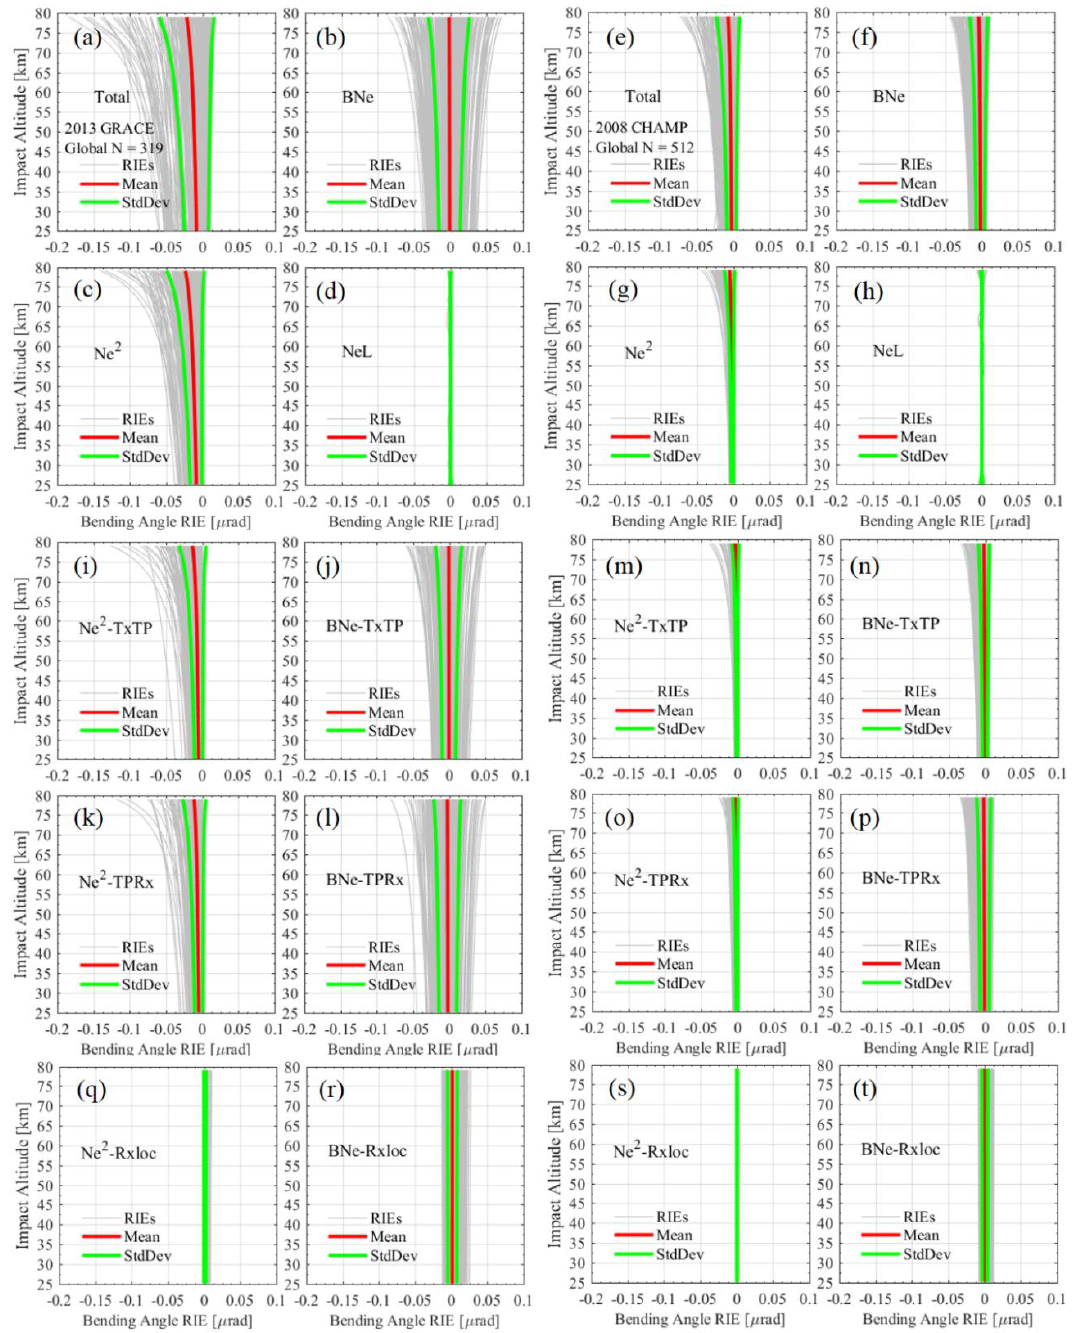
Figure 6. Bi-local bending angle RIE correction profiles and their statistics for the global ensemble high solar activity data set (left columns, the Gravity Recovery And Climate Experiment (GRACE) mission on 15 May and 15 July 2013) and low solar activity data set (right columns, Challenging Mini-satellite Payload (CHAMP) mission on 14–16 July 2008). In the upper composite panels (top two rows), the total bi-local bending angle correction (Total) and its BNe, Ne 2 , and NeL component terms are shown by subpanels ( a – d ) and ( e – h ). The lower composite panels (third and fourth row) show the inbound (TxTP) and outbound (TPRx) components of the Ne 2 and BNe terms, in panels ( i – l ) and ( m – p ), respectively. The bottom row panels show the Rx local (Rxloc) component of the Ne 2 and BNe terms, in panels ( q , r ) and ( s , t ), respectively.